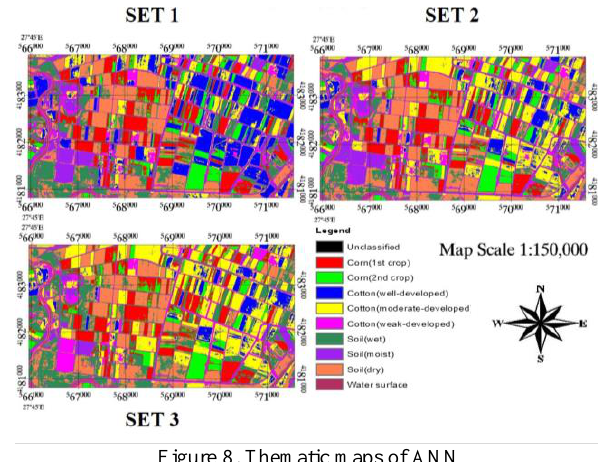
Figure 8. Thematic maps of